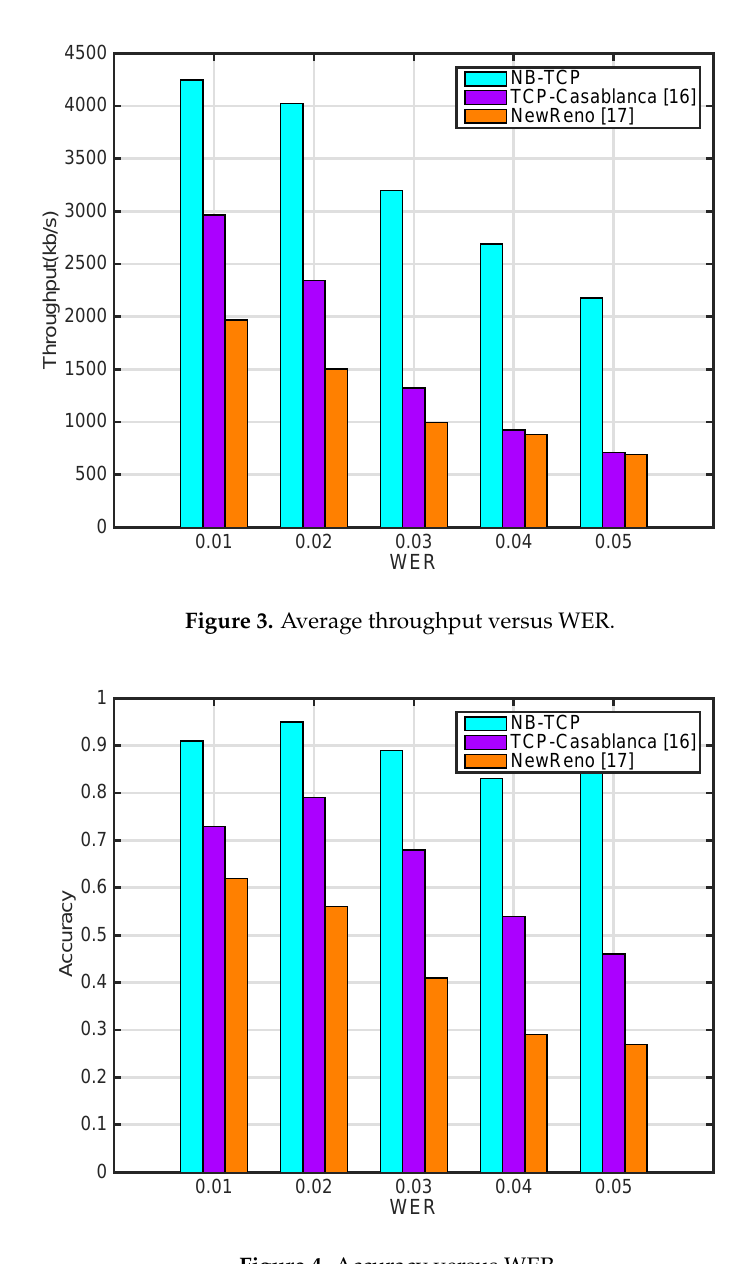
Figure 4. Accuracy versus